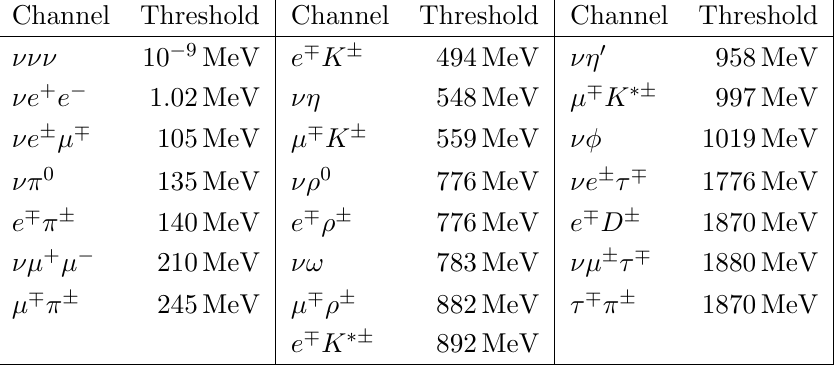
mass are listed above, s